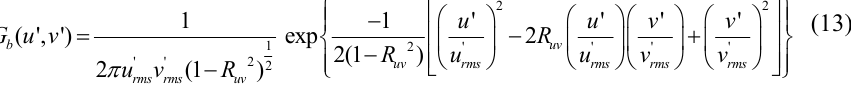
e the fluctuating velocity components e their corresponding root-mean square values, whi cient defined by